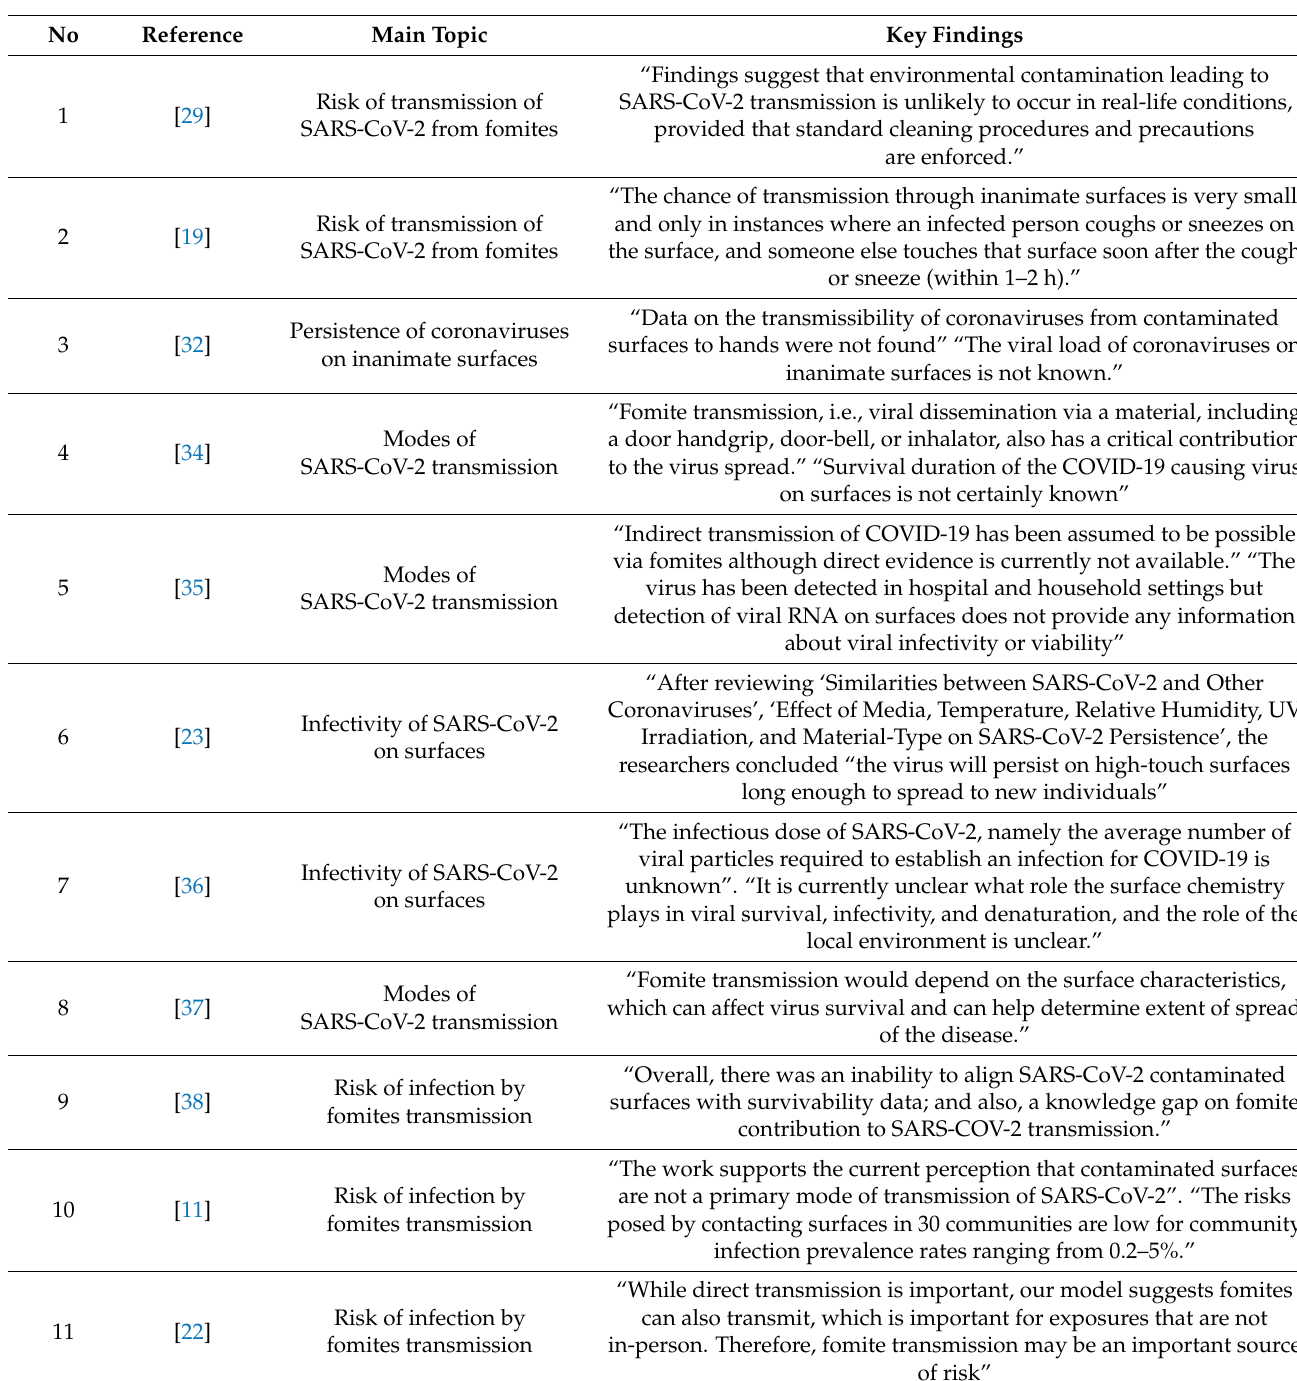
Table A2. Key findings of review